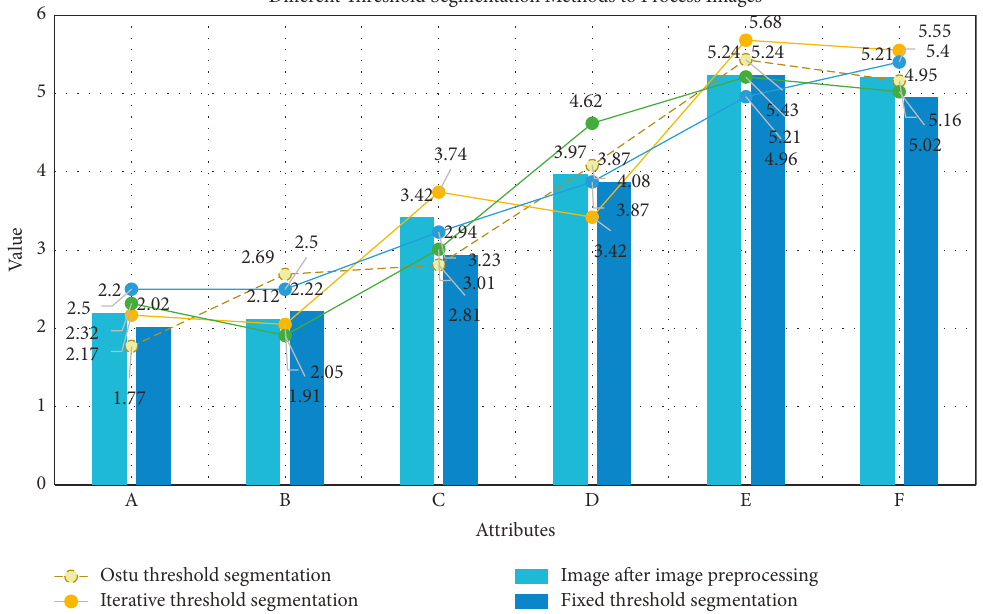
Figure 4: Different threshold segmentation methods to process images. Table 6: Result data table of crack level detected by the